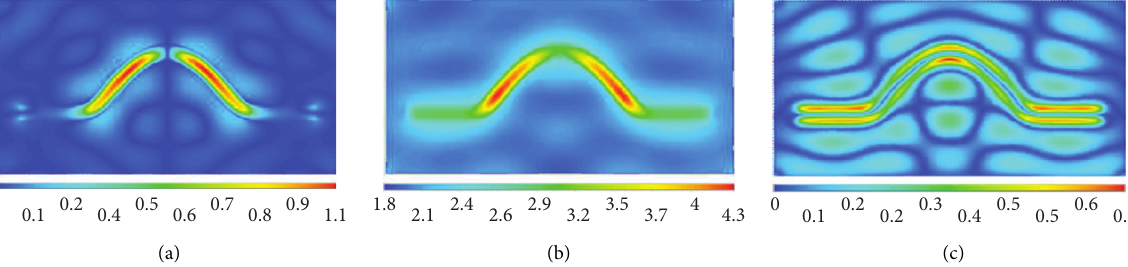
Figure 60: SH wave incident (NR � 1, f � 1.5Hz, H � 100m, and C